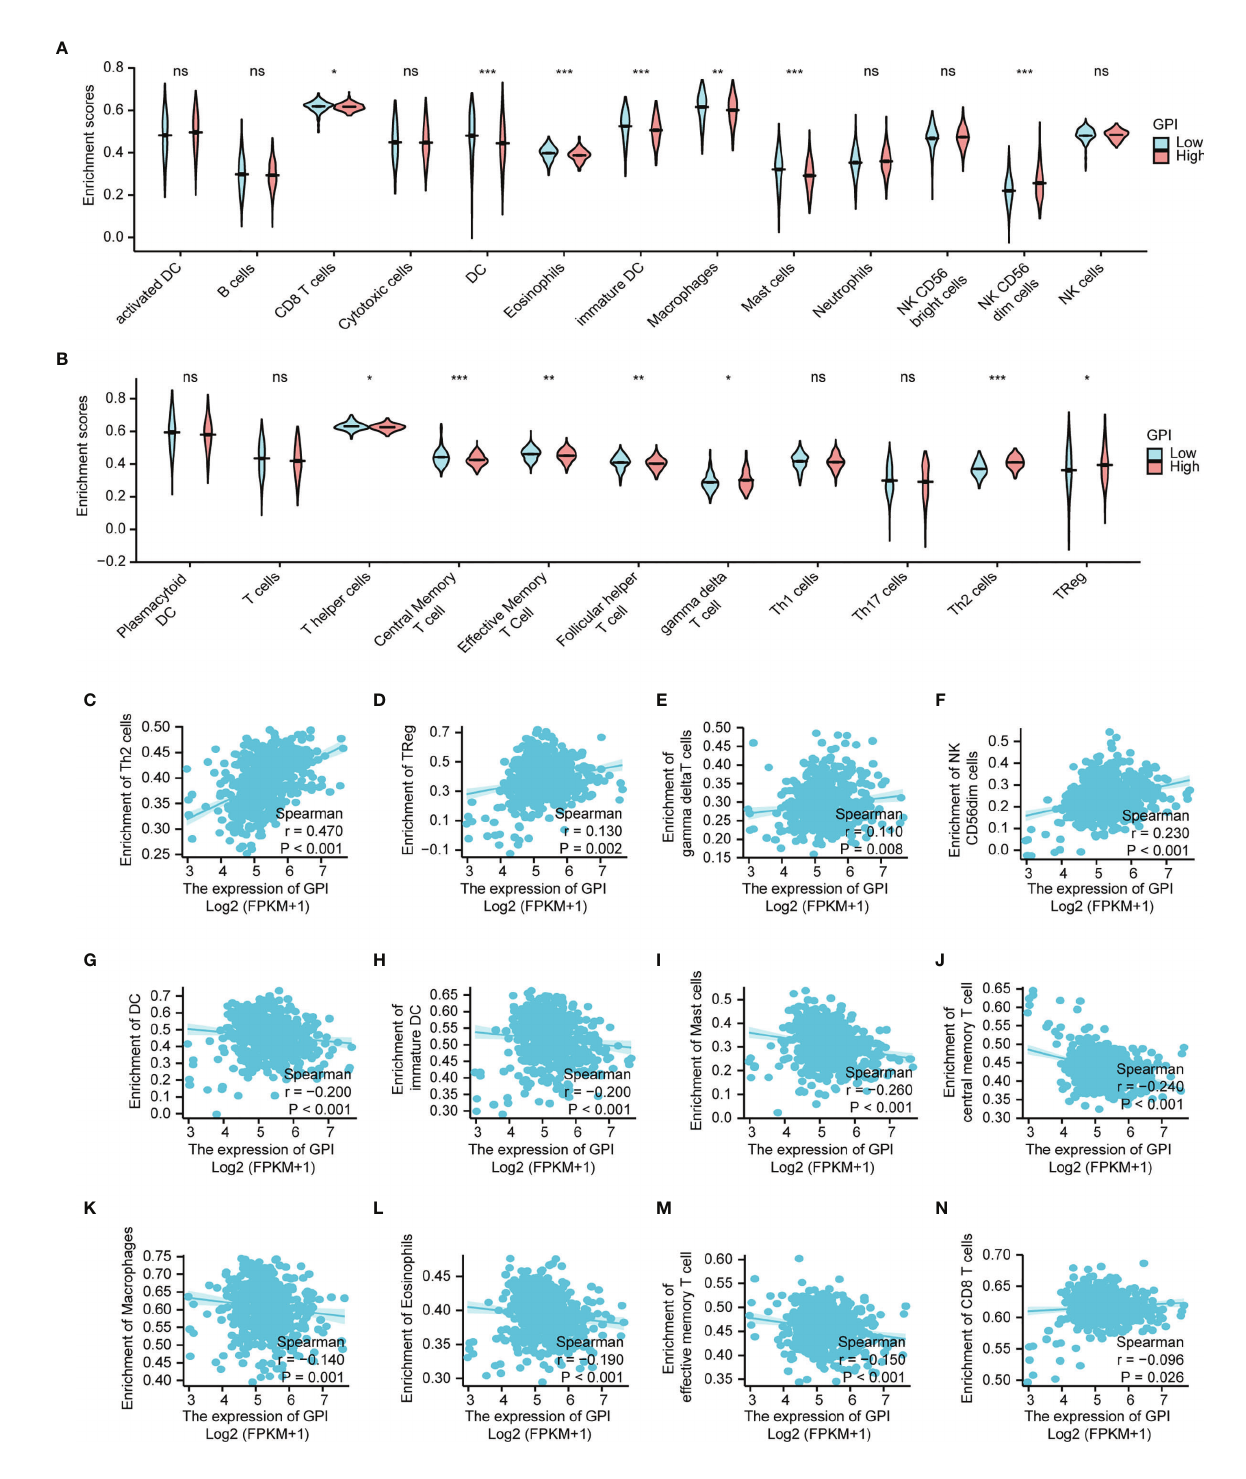
FIGURE 11 | Correlation analysis of glucose-6-phosphate isomerase (GPI) expression and immune in fi ltration in lung adenocarcinoma (LUAD). (A, B) Differential distribution of immune cells in patients with high GPI expression and low GPI expression. (C – N) Correlation between the expression level of GPI and immune in fi ltration in lung adenocarcinoma (LUAD): (C) Th2 cells, (D) regulatory T cells, (E) gamma delta T cells, (F) NK CD56bright cells, (G) dendritic cells (DC), (H) immature DC, (I) Mast cells, (J) central memory T cells, (K) Macrophages, (L) Eosinophils, (M) effective memory T cell, (N) CD8+ T cells. *p < 0.05, **p < 0.01, ***p < 0.001, ns, no signi fi